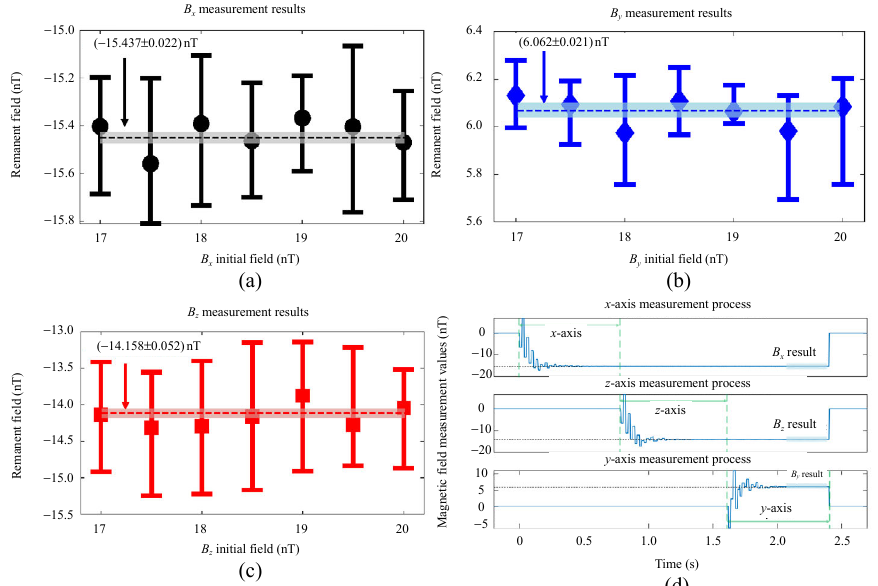
Fig. 5 Experimental values of triaxial residual field components with related estimated uncertainties by the TSA algorithm: (a), (b), and (c) demonstrate the triaxial residual field components, respectively (the weighted averages of global data points in the x , y , and z axes are –15.437 nT, 6.062 nT, and –14.158 nT, with the corresponding uncertainties shown by the hatched region, respectively), and (d) indicates the convergence process of the experimental triaxial magnetic field measurement in the range of [–20 nT, 20